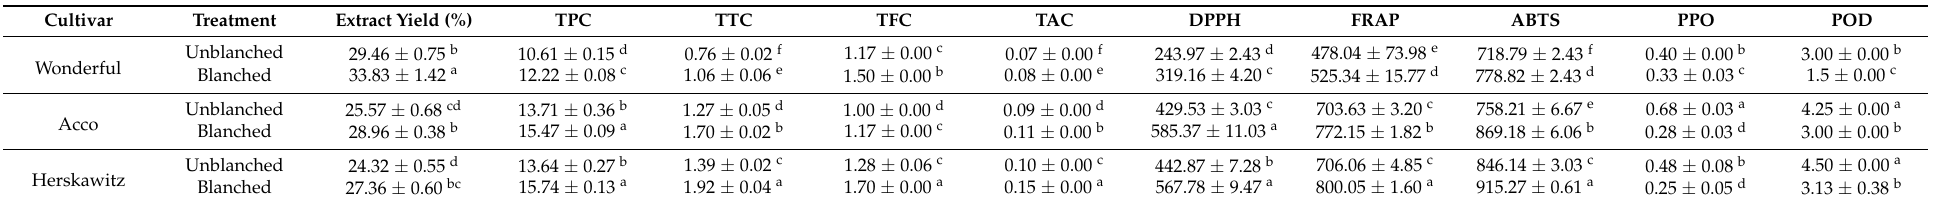
Table 1. Extraction yield, bioactive compounds, enzyme activity, and antioxidant activity of ethanol (70% ( v / v )) extracts from ‘Wonderful’, ‘Acco’, and ‘Herskawitz’ pomegranate peel cultivars at commercial harvest (ripe stage) blanched at 80 ◦ C for 3 min.